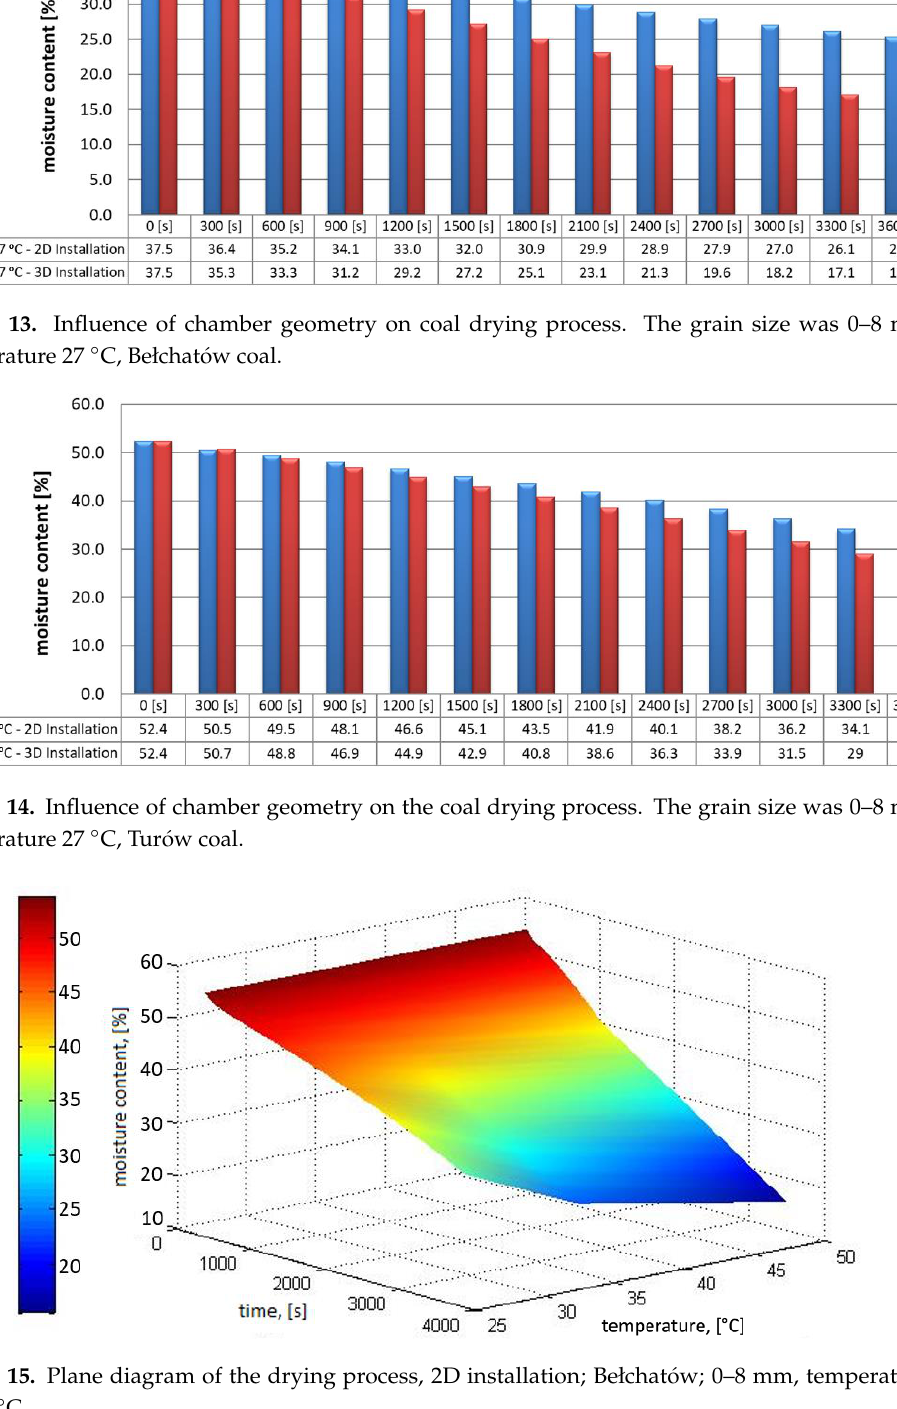
Figure 15. Plane diagram of the drying process, 2D installation; Bełchatów; 0–8 mm, temperature: 27–50 °C.